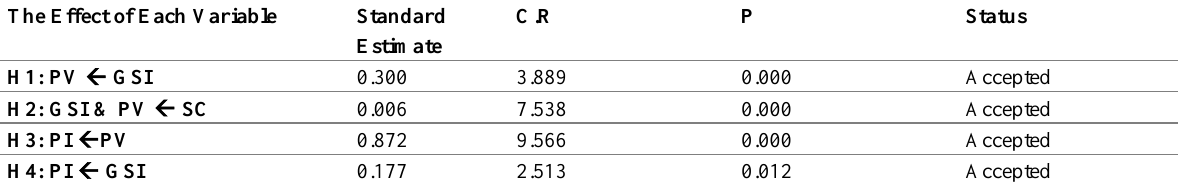
Table 3: Hypothesis Testing: Direct